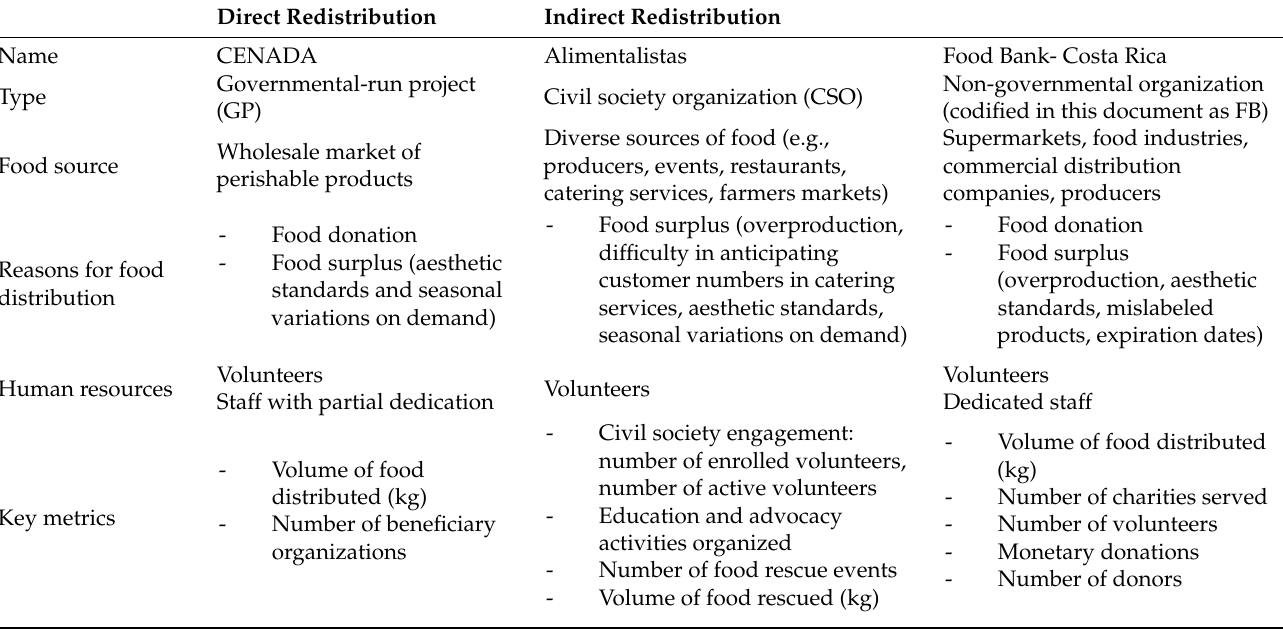
Table 2. Characteristics of the food redistribution actors within the CR-FLW